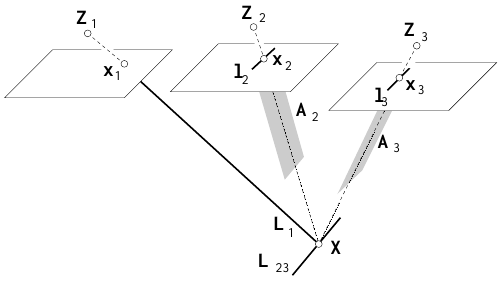
Figure 1. Trifocal constraint. We choose two lines l 2 and l 3 through the image points x 2 and x 3 of the second and third camera. The corresponding projection planes A 2 and A 3 raise the intersection line L 23 . The constraint requires that projection line L 1 and intersection line L 23 intersect in one single